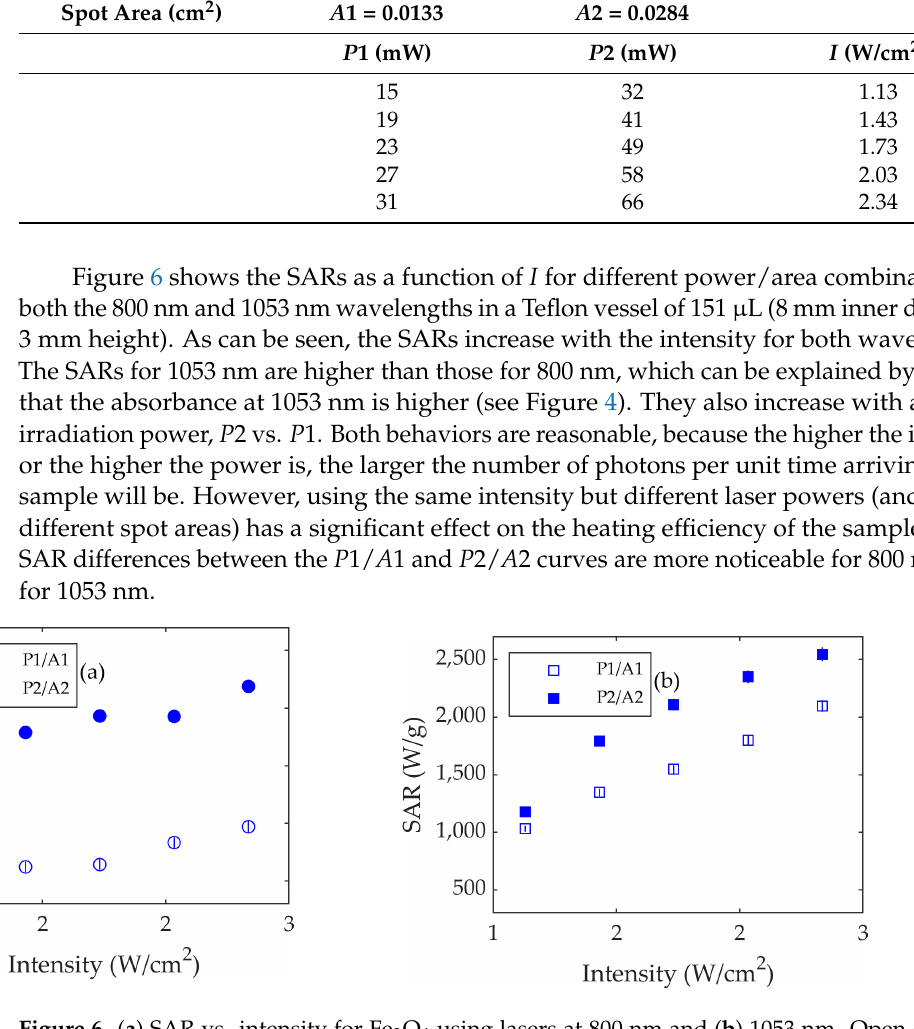
Table 2. Powers used according to the spot diameter (area) to obtain a given intensity of laser radiation. Spot Diameter ( µ m);